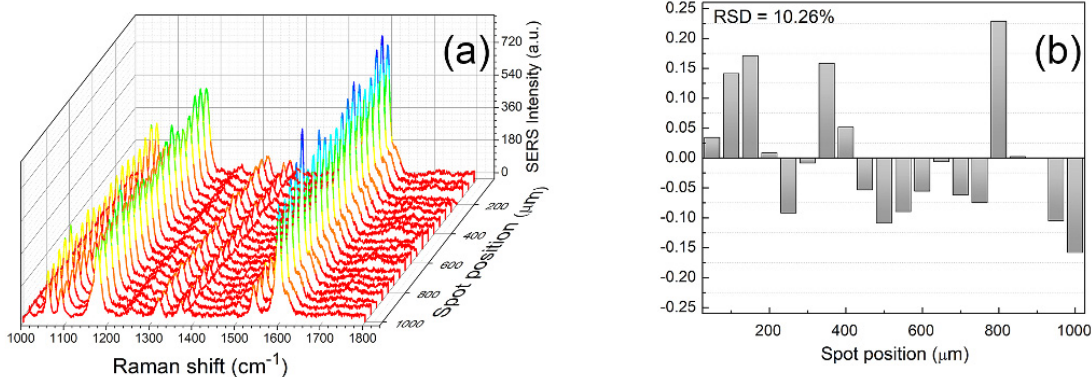
Figure 7. ( a ) SERS spectra obtained during a 1 mm-length linear scan of GNS@Ag300 chips coated with MMC; ( b ) relative RSD values obtained using the integrated intensities of mode at 1170 cm − 1 .